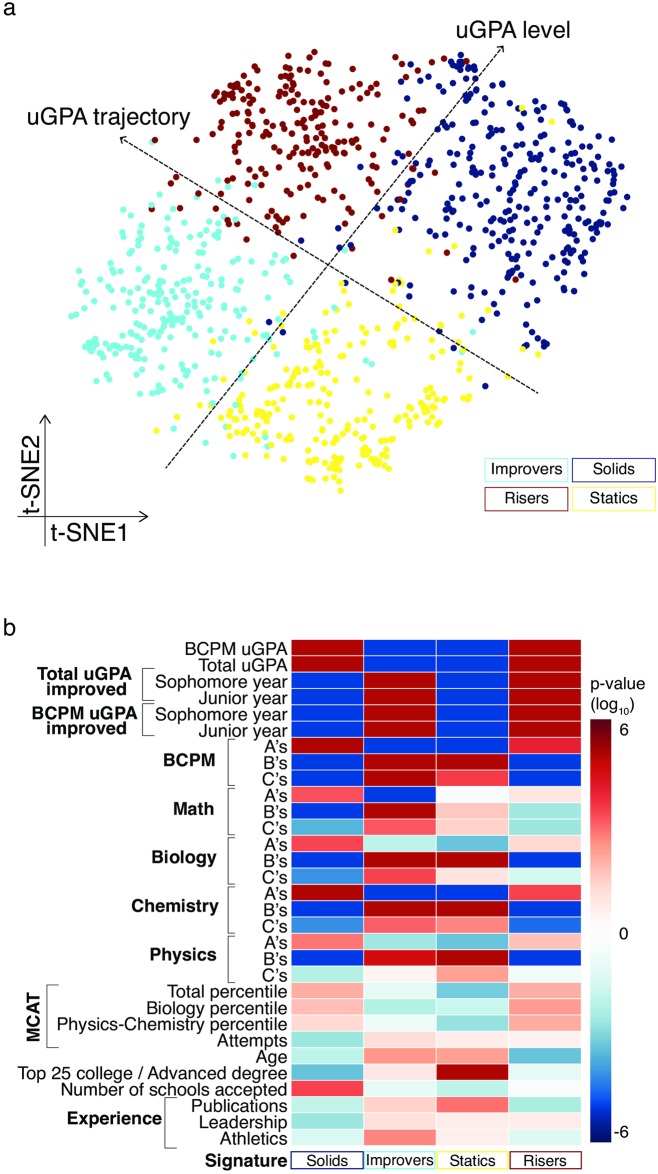
Medical school students can be classified into four signatures based on admissions data.(a) Embedding the 23-feature-space student data into a two-dimensional space, using t-SNE analysis [25], allows us to visualize similarities among students, and reveals four clusters. Each dot indicates a student and is colored by the K-means clustering (see Materials and methods). The different colors correspond to the four different signatures. (b) Characteristics of the signature features. For each signature, the heat-map indicates the enrichment (-log10
P-value) for each of the features shown (see Materials and methods). Only those 31 out of 53 features with a significant value (P < 0.01) in at least one signature are shown.